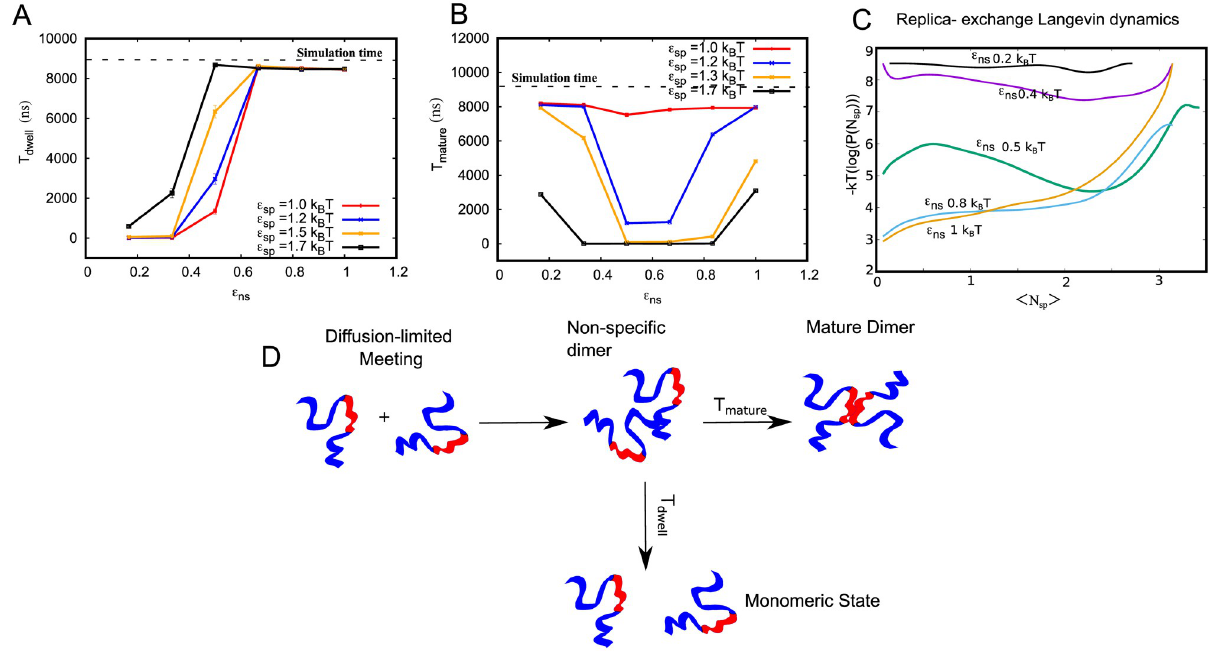
Fig 3. Key timescales characterizing maturation dynamics. A) Mean dwelling time in the dimeric state (T dwell ) as a function of non-specific interaction strength ( � ns ) and different � sp . B) Mean maturation time, reorganising time from non-specific dimer to mature dimer as a function of � ns for different values of � sp (smoothed solid curves are a guide to eye). C) Free energy as a function of specific contacts per bead computed using replica exchange langevin dynamics simulations. Individual free energy curves represent simulations performed at different values of � ns . For an � ns = 0.5k B T (green curve), there is a sharp minima for higher value of specific contacts per bead. For high and low values of � ns this minima is not observed, suggesting that there is an optimal value of � ns at which functional dimers are favored. D) Schematic representation of the key events en route to forming a mature dimer. Interaction partners meet at timescales that are diffusion-limited. Upon initial meeting, the dimers are in contact due to non- specific interactions. This non-specific dimer could then either diffuse away at a typical timescale of T dwell or reorganize to form a mature, functional dimer with a characteristic reorganisation time of T mature